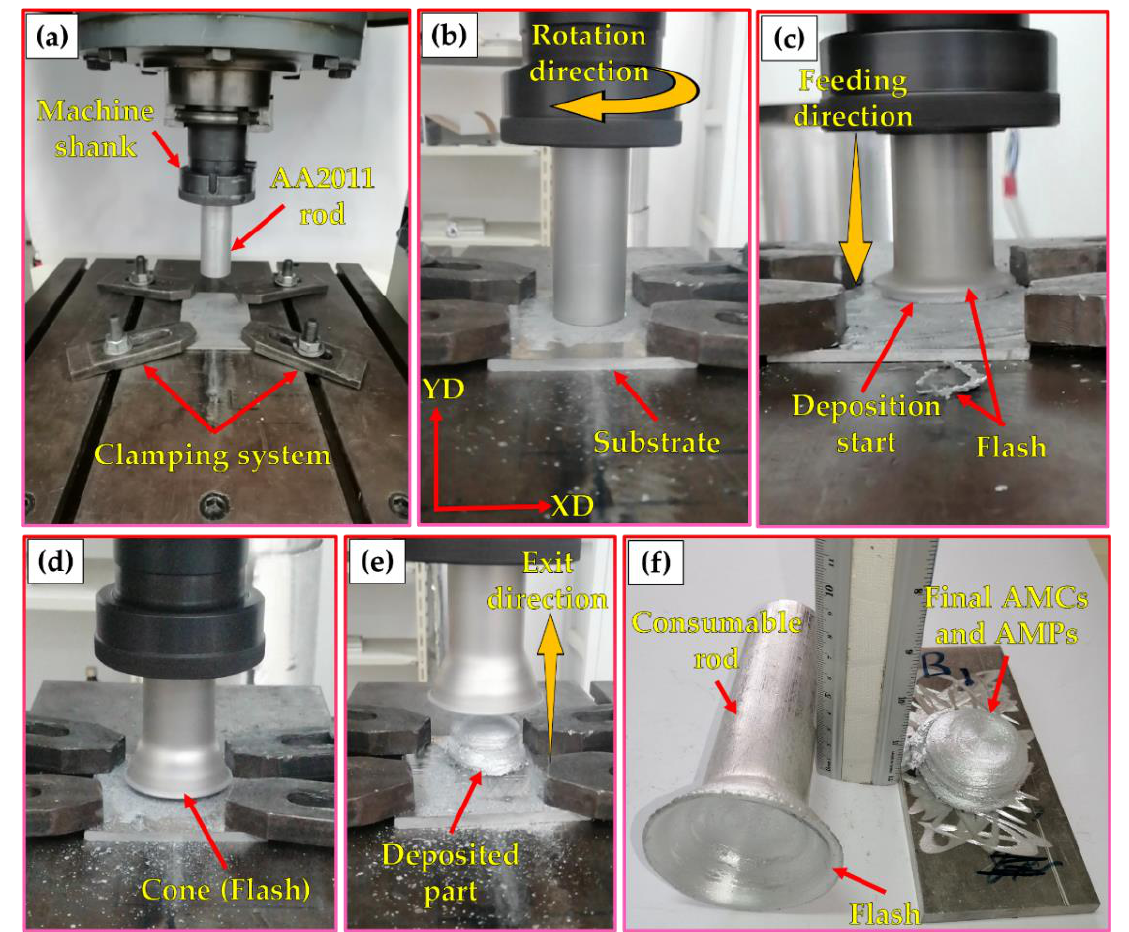
Figure 3. Photographs of the FSD process of AA2011: ( a ) setup of FSD and the consumable rod and